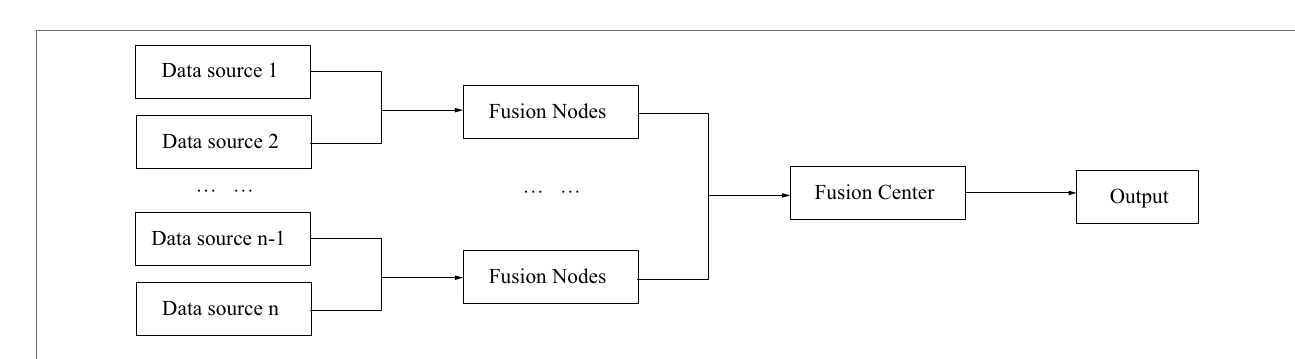
FIGURE 5 | Information fusion without feedback hierarchical